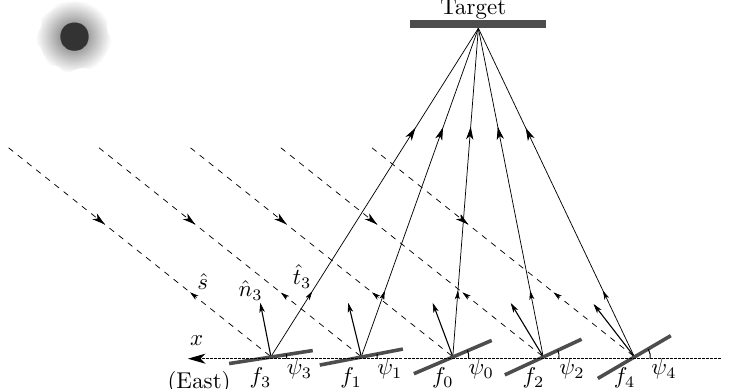
Figure 2. Incident and reflected vector projections on the rotation plane of the